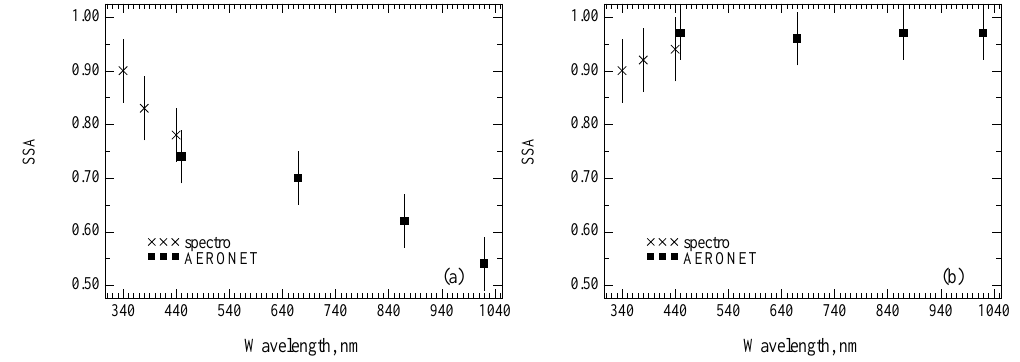
Fig. 5. Spectral variations of SSA retrieved from spectroradiometer’s measurements at 340, 380 and 440nm (crosses) and from AERONET/PHOTONS at 440, 675, 870 and 1020nm (squares): (a) 29 January 2006 at 11:00UTC; (b) 11 September 2006 at 13:30UTC. Vertical bars correspond to SSA uncertainties.